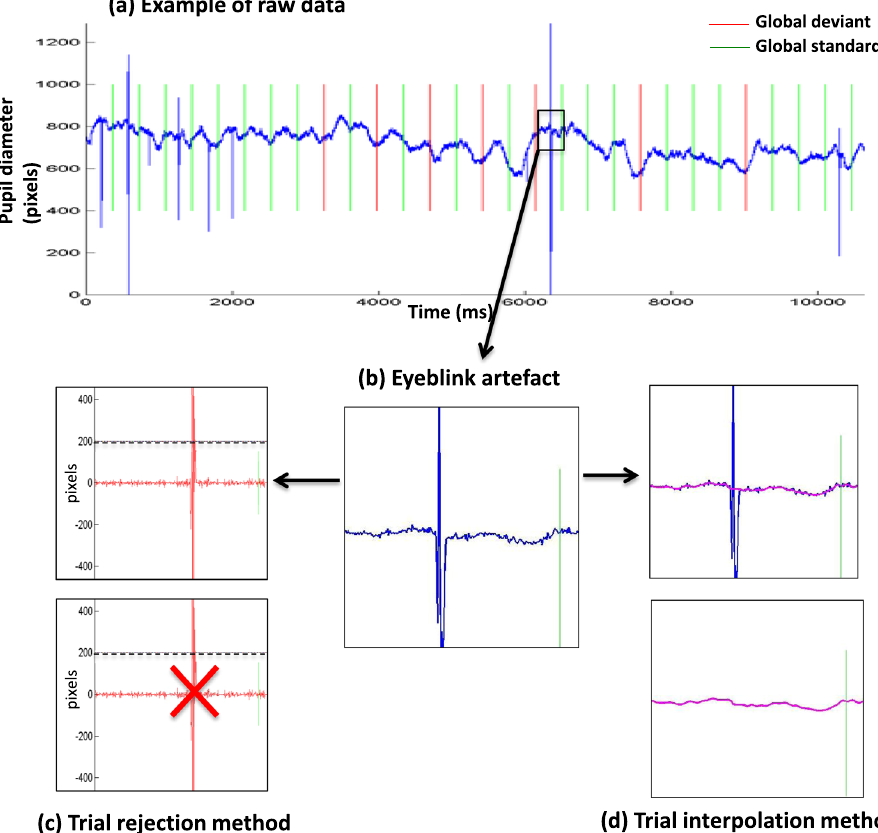
Figure 2. Raw data and two methods to process eye-blink artefacts ( a ) Example of raw data (blue curve): temporal evolution of pupil horizontal diameter (in pixels) from the right eye of one participant, superimposed with global standard trials in green and global deviant trials in red. ( b ) Zoom on a trial with an eye blink artefact processed with two different methods. ( c ) With the trial rejection method a trial was rejected if the difference between two successive temporal points was larger than 200 pixels. ( d ) With the trial interpolation method (see details in the text) any identified artefact (blue) was corrected using a cubic interpolation (bottom magenta